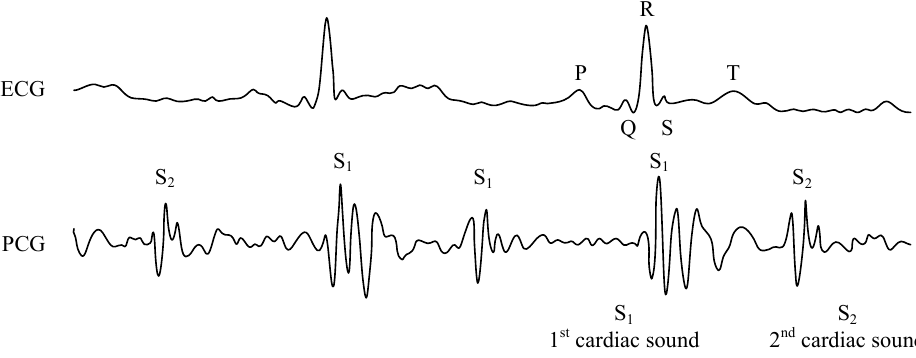
Figure 1. Sample recordings of electrocardiogram (ECG) and phonocardiography (PCG)